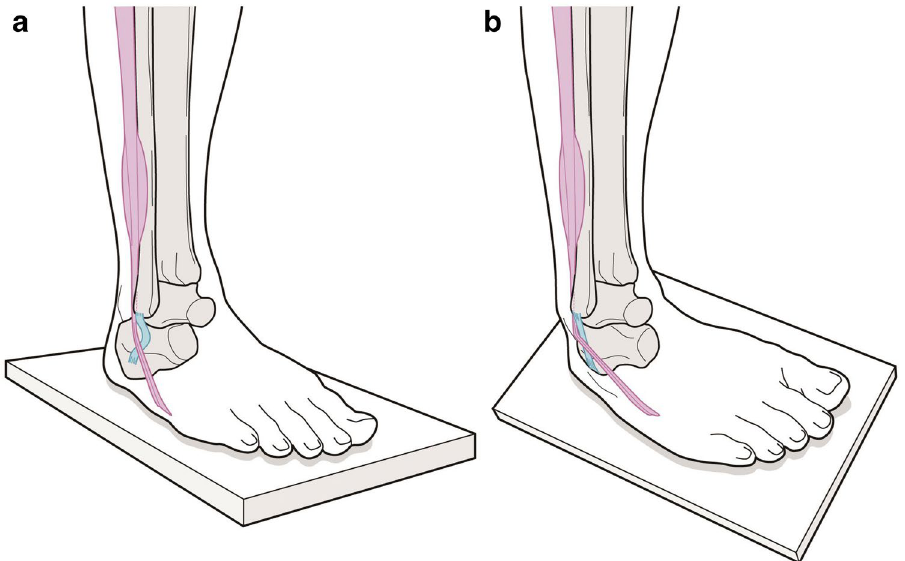
Figure 5. A schematic drawing of the tensioner effect by the calcaneofibular ligament (CFL). ( a ) The foot is in a neutral position on flat ground. The CFL (light blue) is loose and has no functional interaction with the peroneal tendons (pink). ( b ) When the foot is impelled in an inversion position on uneven terrain, the CFL lifts the PLT and PBT and may contribute to rapid joint action by effectively transmitting muscle contraction. PLT peroneus longus tendon, PBT peroneus brevis